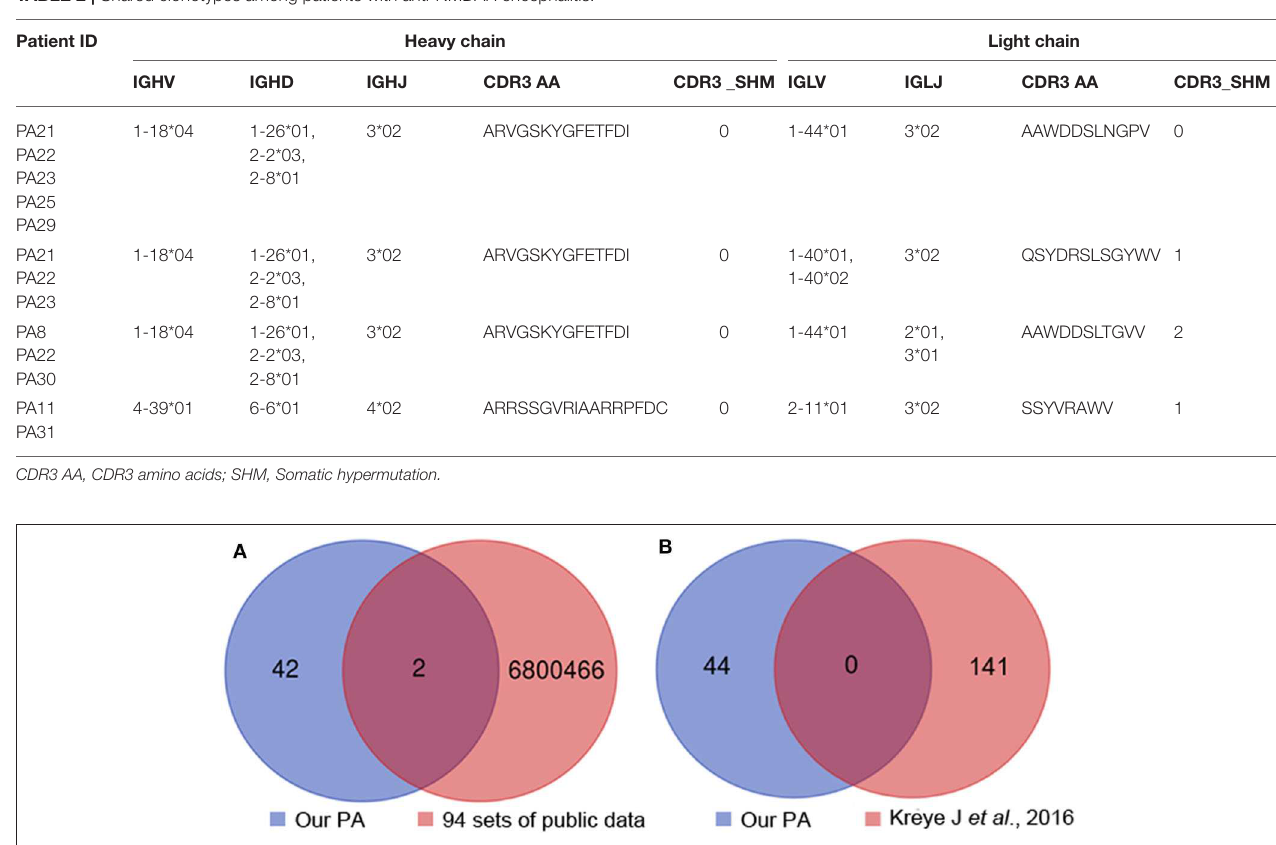
FIGURE 3 | Heavy chain common clones between the 12 patients, 94 sets of healthy people’s public data (A) and previous report (B) . PA,